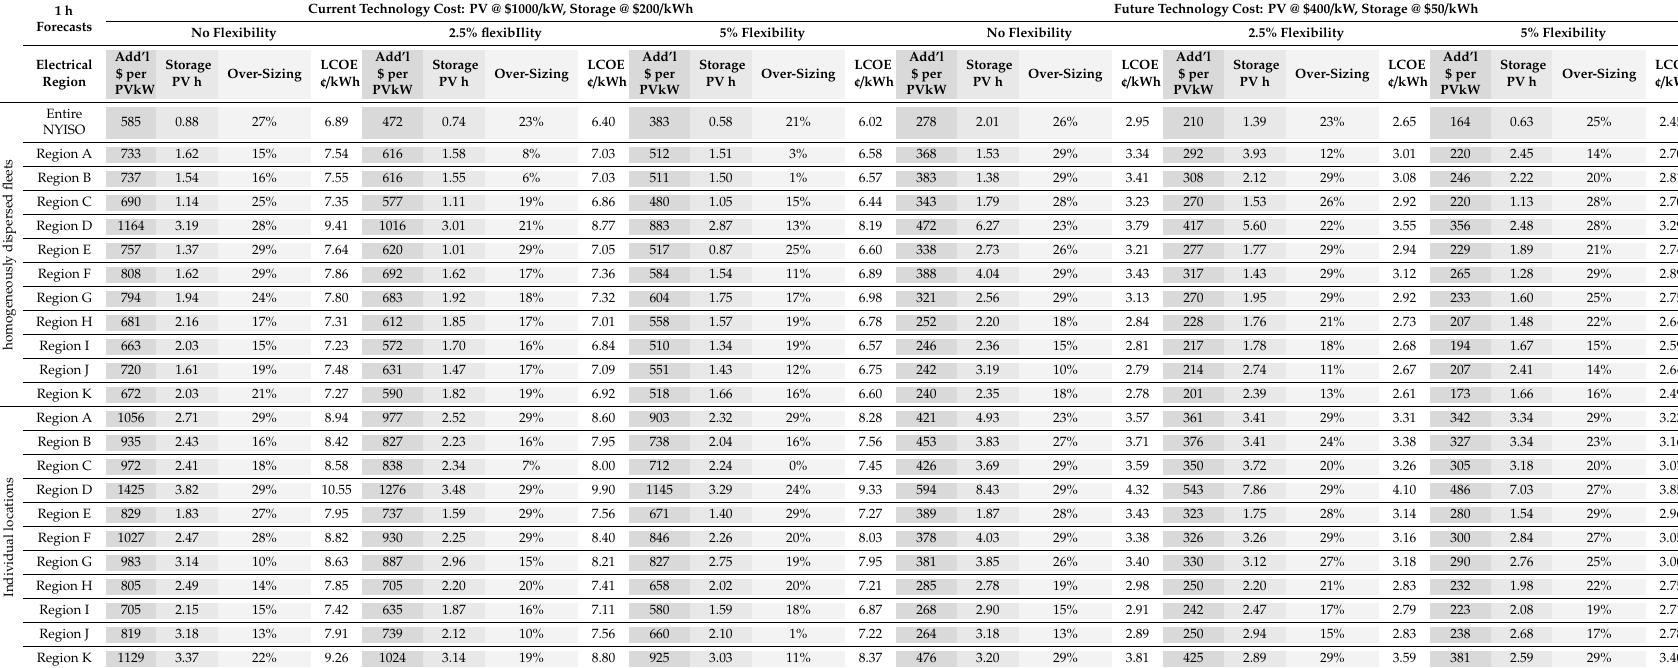
Table A2. One-hour-ahead firm forecast results applying